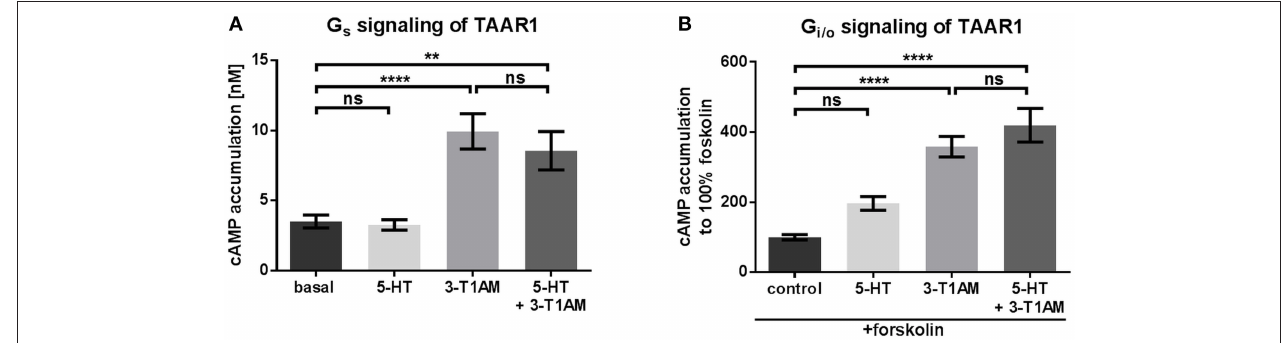
FIGURE 1 | 3-T1AM, but not 5-HT induces G s signaling via TAAR1 in a concentration of 10 µ M. To measure G s and G i / o , the cAMP content was determined via AlphaScreen technology. HEK293 were used to overexpress TAAR1. An empty vector was used for mock transfection, which showed no endogenous effect of 5-HT or 3-T1AM (see Supplemental Figures 1A,B). (A) TAAR1 was stimulated with either 5-HT or 3-T1AM or both in a concentration of 10 µ M. n = 7 measured in triplicates. (B) TAAR1 was stimulated with forskolin and either 5-HT or 3-T1AM or both in a concentration of 10 µ M. Results of four independent experiments performed in triplicates are shown. For statistics, a one-way ANOVA was performed and the mean of each column compared with the mean of all other columns. Statistical significance was defined as ** p ≤ 0.01, **** p ≤